Question: What type of chart is this?
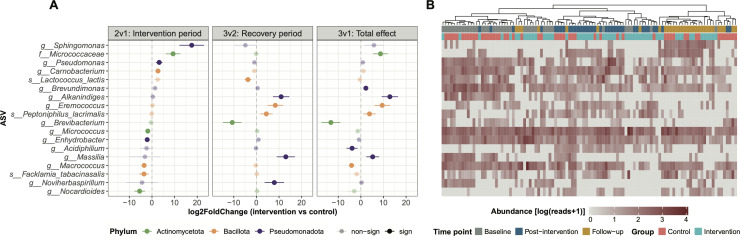
Answer: heatmap